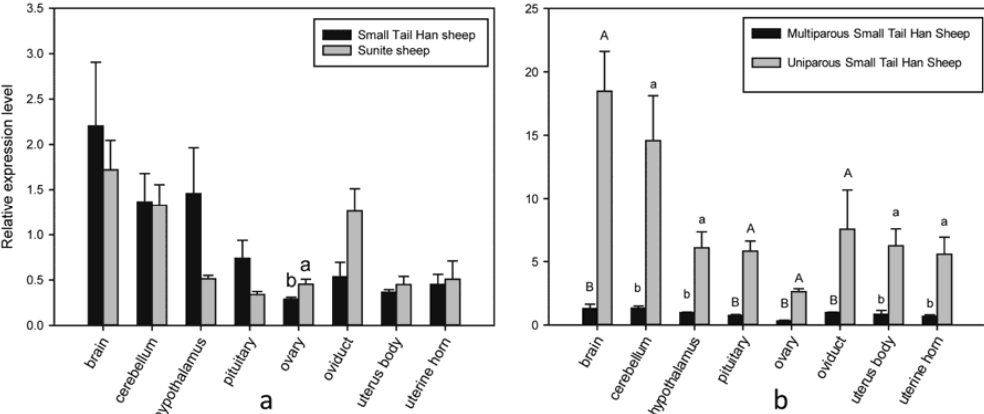
Figure 2. Expression of HIRA in reproductive tissues of sheep. ( a ) Expression of HIRA in reproductive tissues of high fecundity Small Tail Han sheep and low fecundity Sunite sheep; ( b ) Expression of HIRA in reproductive tissues of multiparous and uniparous Small Tail Han sheep. Note: Different small letters in the same group mean significant difference ( p < 0.05), different capital letters in the same group mean highly significant difference ( p <